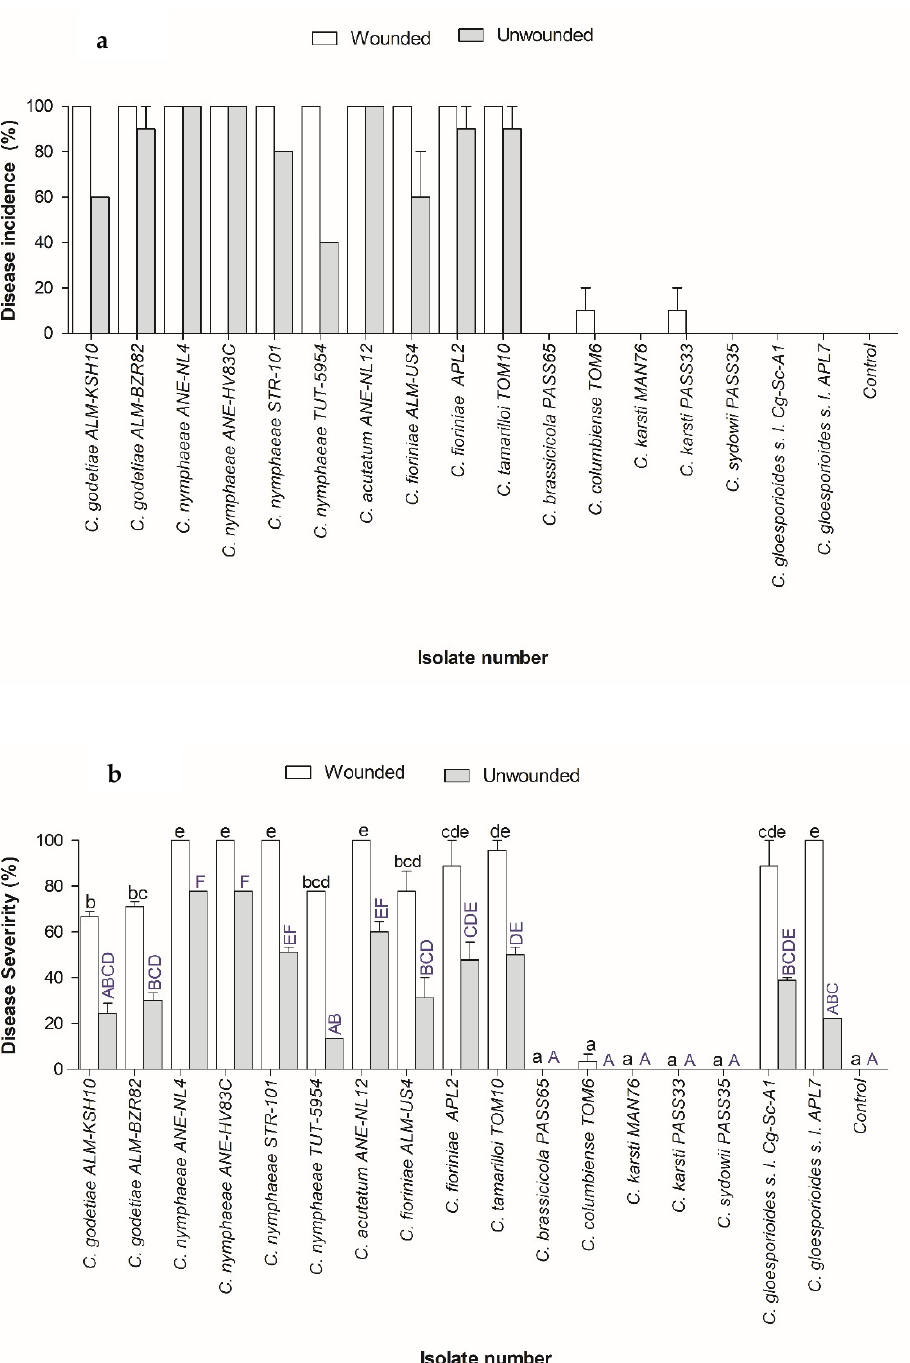
Figure 4. Anthracnose lesions on detached unwounded (UW) and wounded (W) strawberry fruits 7 days after inoculation for each representative isolate and species, within each Colletotrichum spe- cies complex used in this study.